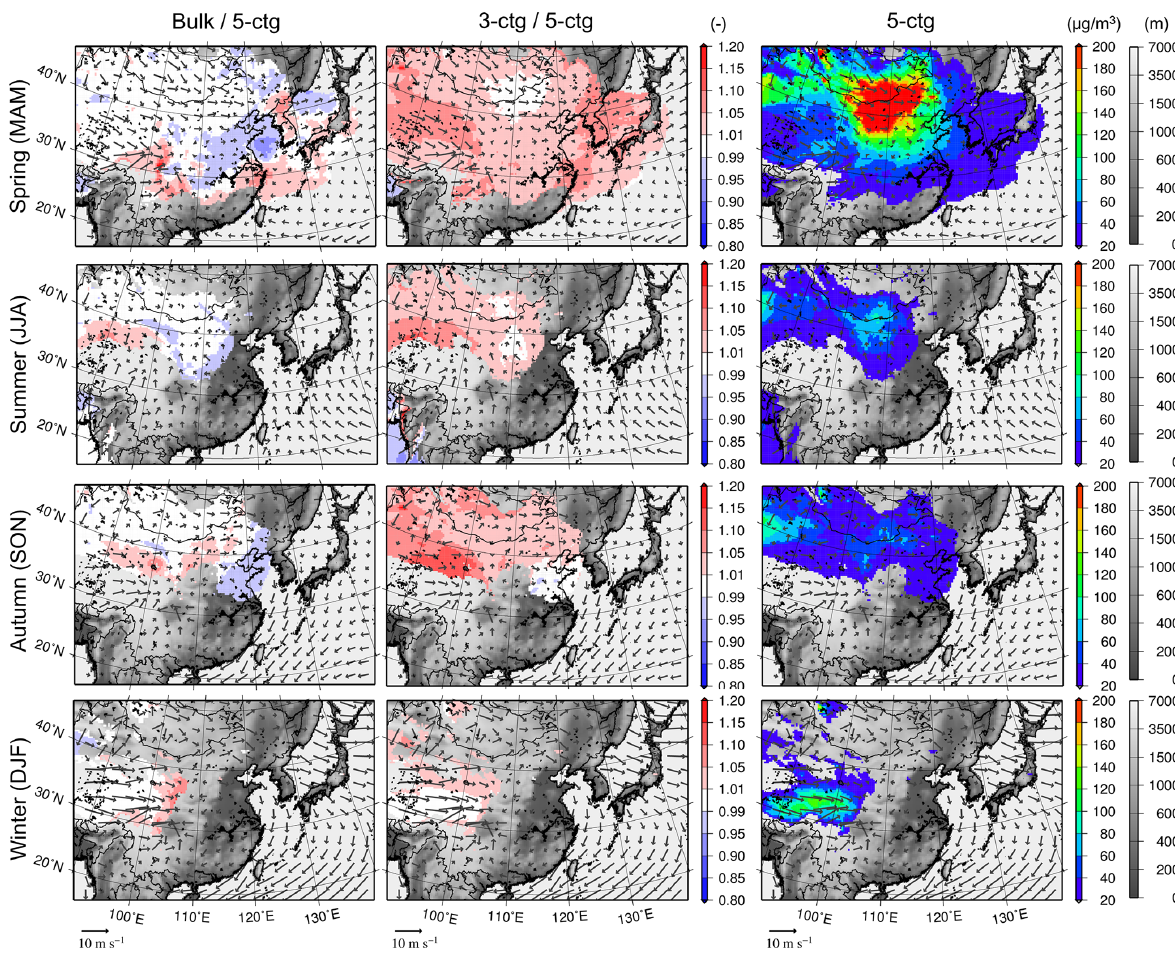
Figure 4. Same as Fig. 3 but for mineral